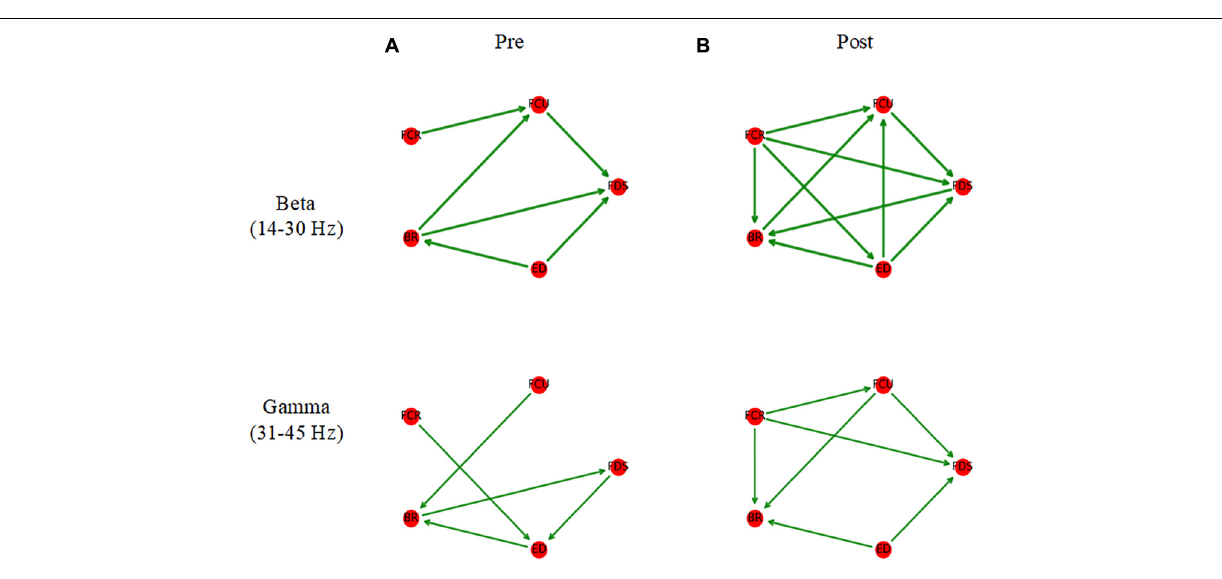
FIGURE 6 | Average muscle networks pre- (A) and post-muscle fatigue (B) . The arrows indicate the stronger information flow direction, and the edge width is positively correlated with the strength of information flow. The average values of beta- and gamma-bands TDMIC before fatigue were used as display thresholds respectively to make network topology